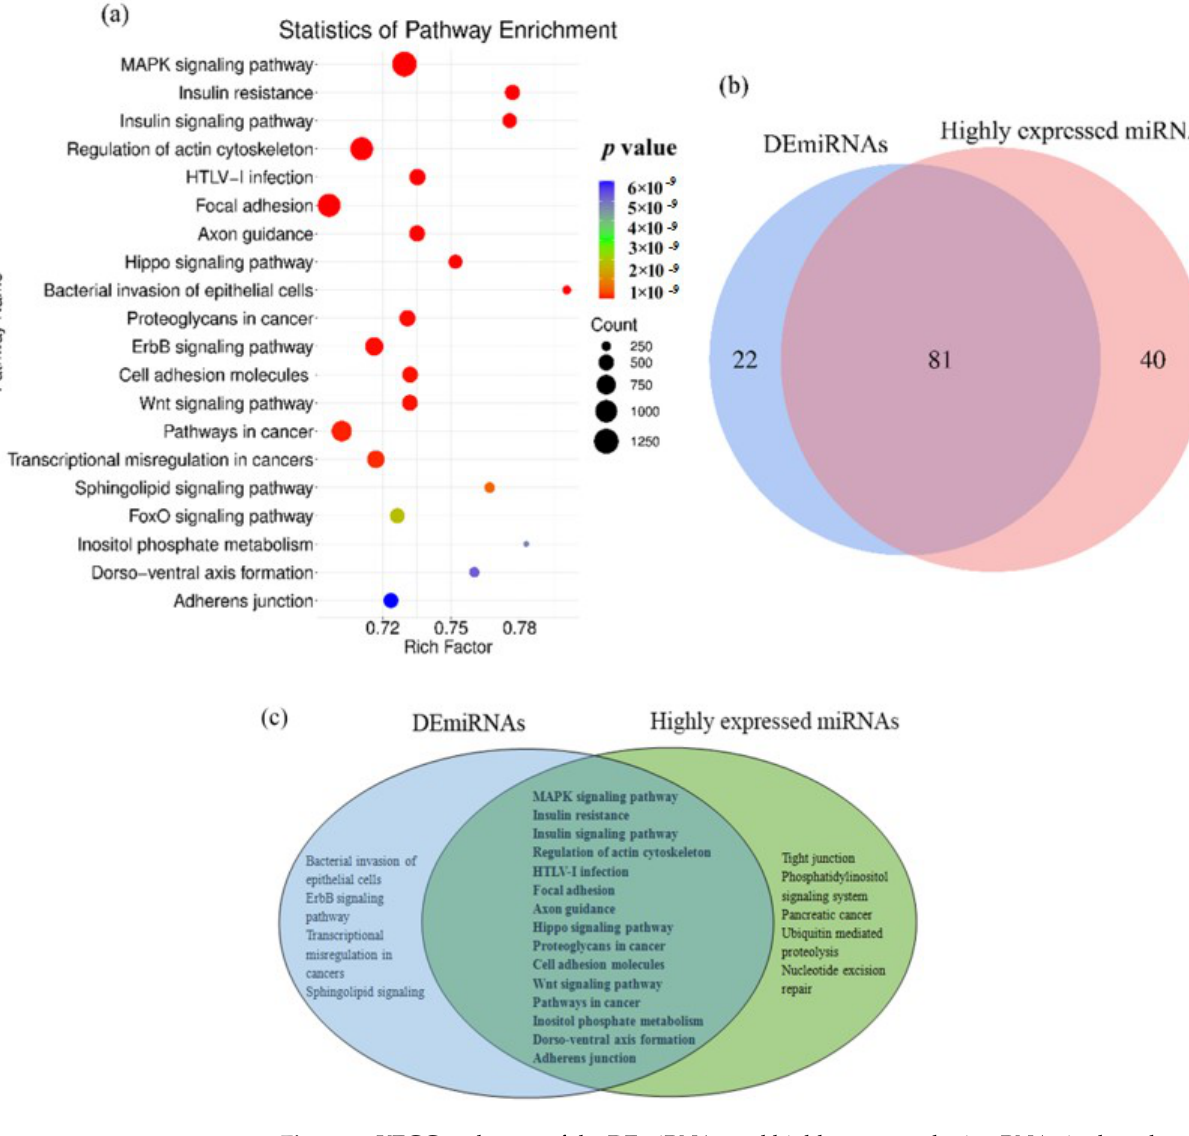
Figure 2. KEGG pathways of the DEmiRNAs and highly expressed microRNAs in the colon of goats at the preregurgitation stage. ( a ) Top 20 enriched KEGG pathways of the DEmiRNAs. ( b ) Venn diagram of the enriched pathways of DEmiRNAs and highly expressed microRNAs. ( c ) The overlap pathways between the DEmiRNAs and the highly expressed